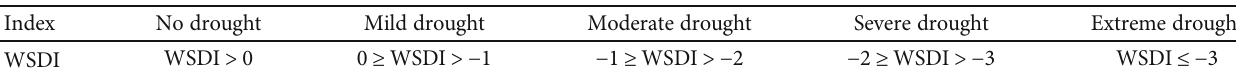
Table 3: WSDI categories